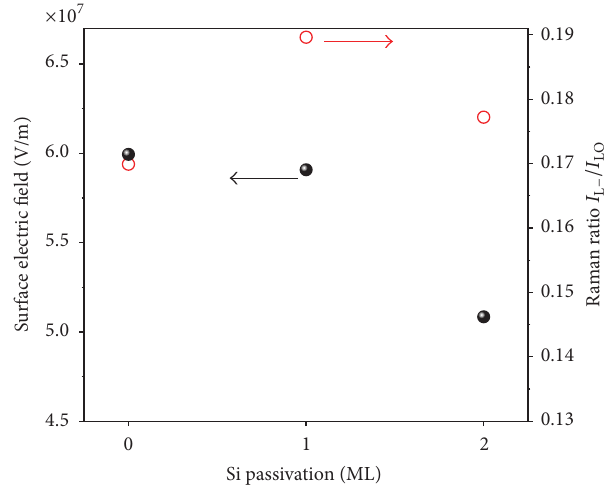
Figure 10: Behavior comparison of the surface electric field obtained by PR (black point) and Raman ratio 𝐼 as a function of